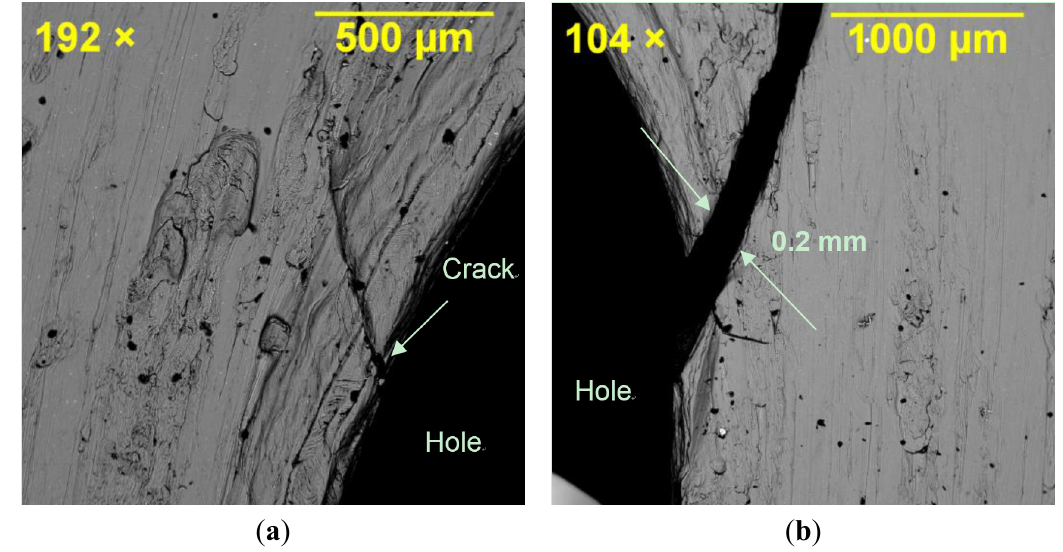
Figure 10. Crack opening at the shear-out region of the hole in SW1e1 specimen: